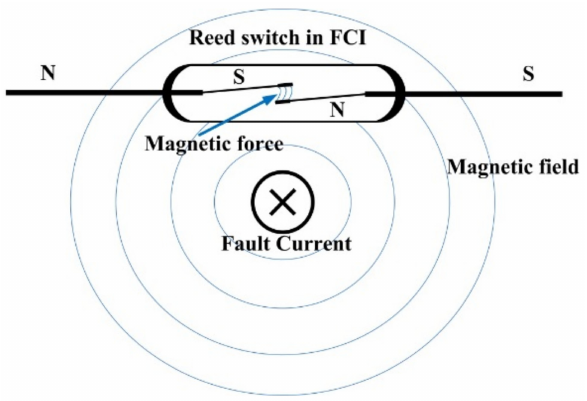
Figure 1. Concept of a reed-switch-based Fault Current Indicator (FCI).